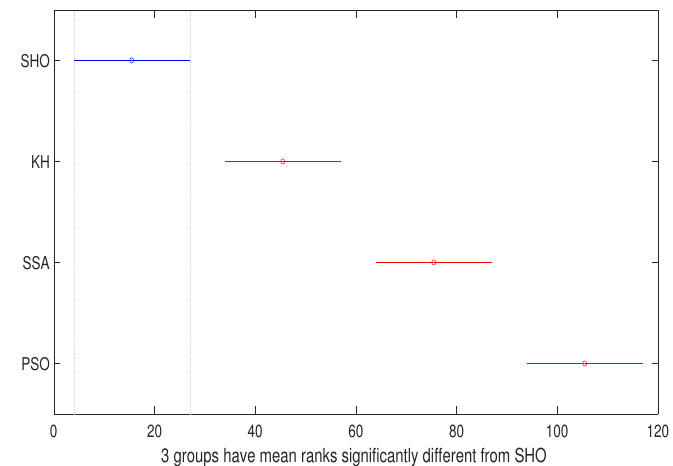
Figure 5. Computational times Tukey